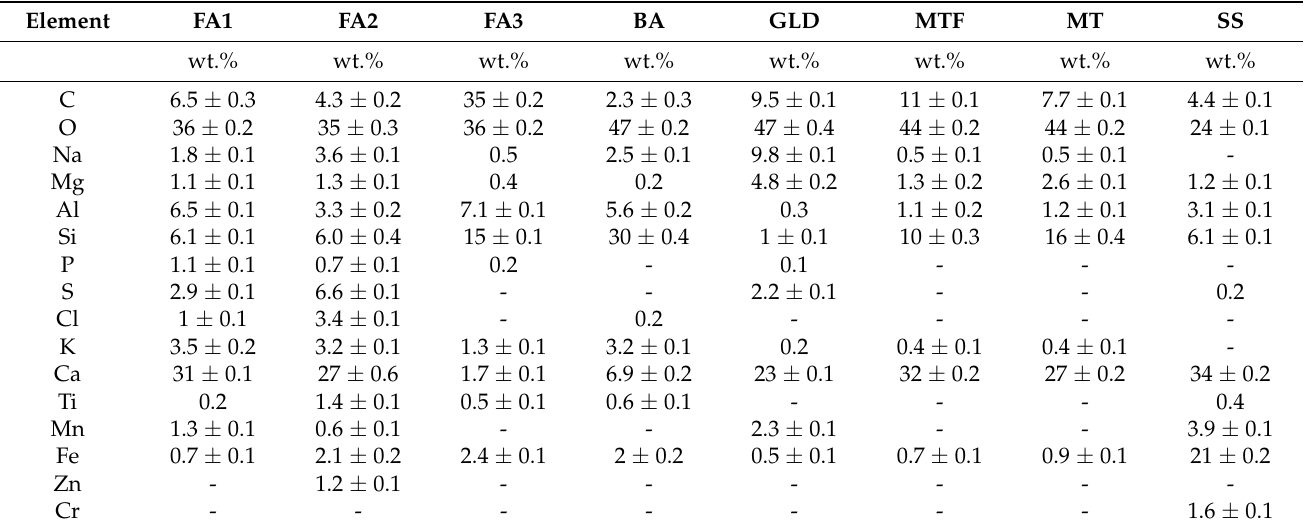
Table 5. Chemical compositions of the samples obtained with EDS analysis; values expressed in wt.%. Element